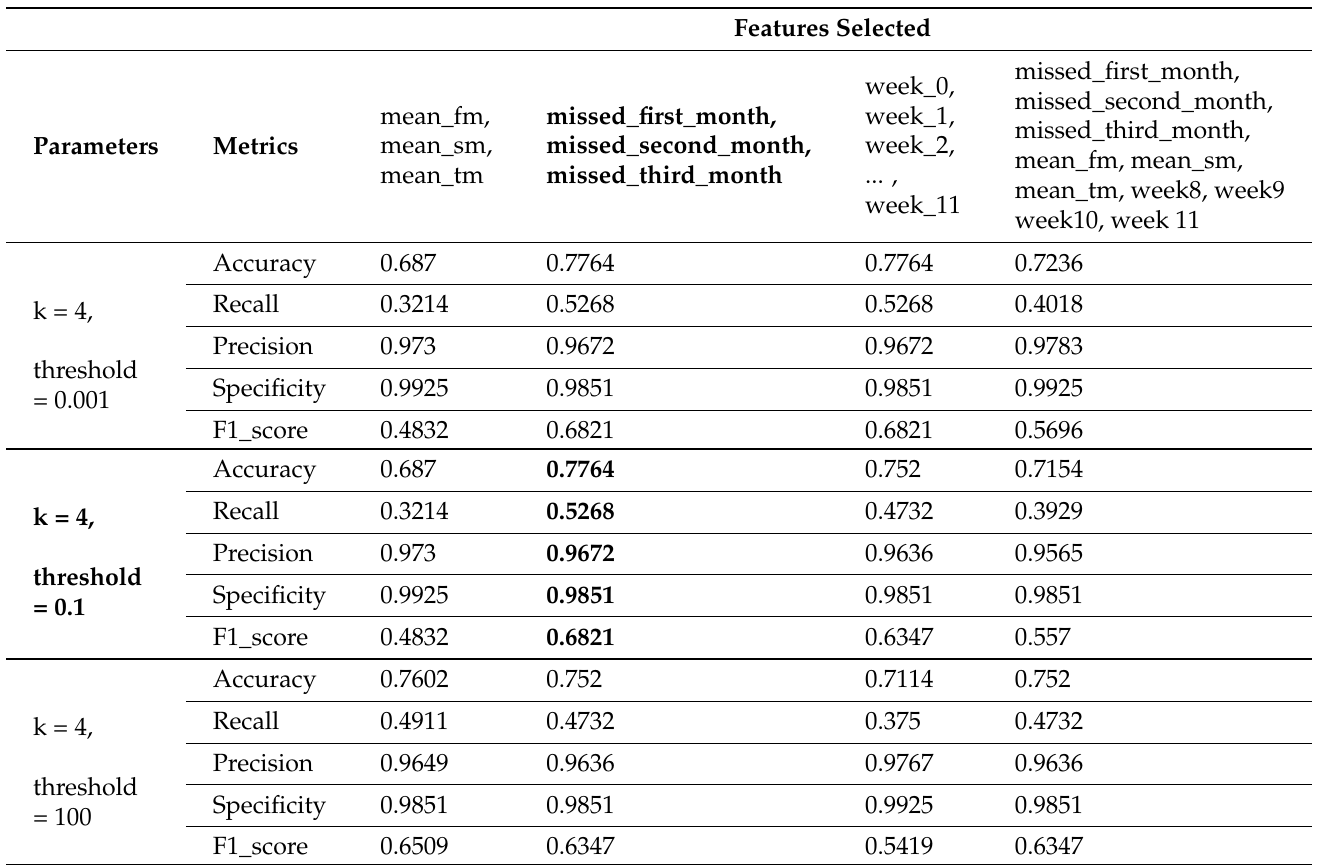
Table 15. Metrics, applying different configurations for BIRCH clustering—SVR. Features Selected